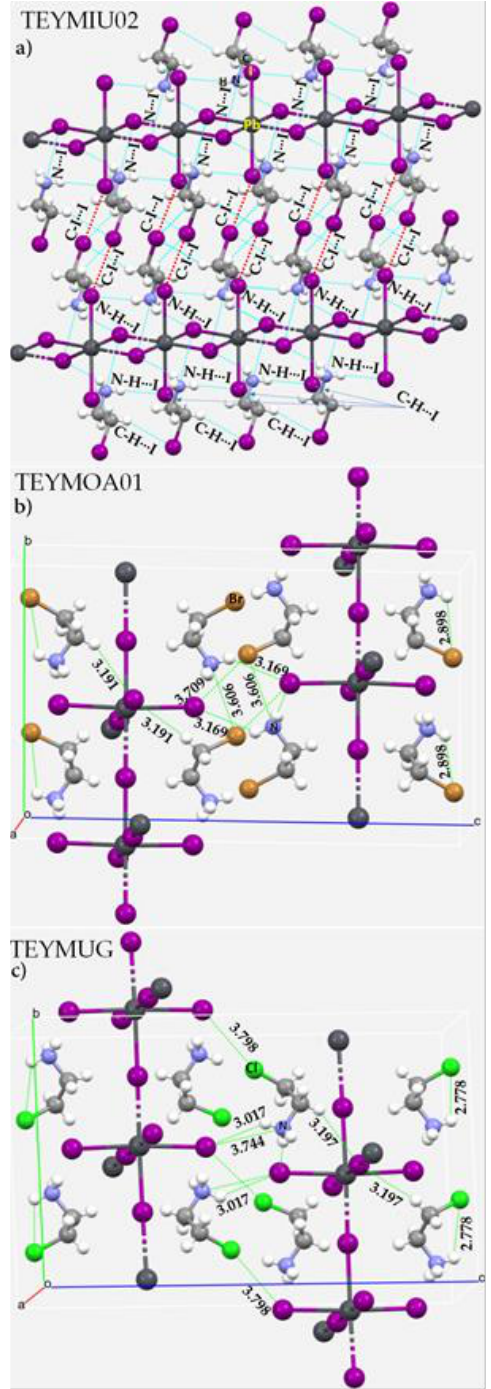
Figure 18. ( a ) Illustration of the nature of C-I ··· I halogen bonding, N ··· I pnictogen bonding, N–H ··· I and C–H ··· I hydrogen bonding interactions in the extended and unit-cell crystals of (I − (CH 2 ) 2 − NH 3 ) 2 PbI 4 . Shown in ( b , c ) are an illustration of the nature of Br ··· I and Cl ··· I halo- gen bonding, and N–H ··· I and C–H ··· I hydrogen bonding interactions in the unit-cell crystals of (Br − (CH 2 ) 2 − NH 3 ) 2 PbI 4 and (Cl − (CH 2 ) 2 − NH 3 ) 2 PbI 4 , respectively. The intramolecular N–H ··· X (cid:48) hydrogen bonding interaction in the cis conformation of X (cid:48) − (CH 2 ) 2 − NH 3 + (X (cid:48) = Br, Cl) is marked in ( b , c ). Labeling of selected atoms, as well as CSD reference codes in upper-case letters, is shown in all cases. Selected bond distances are in